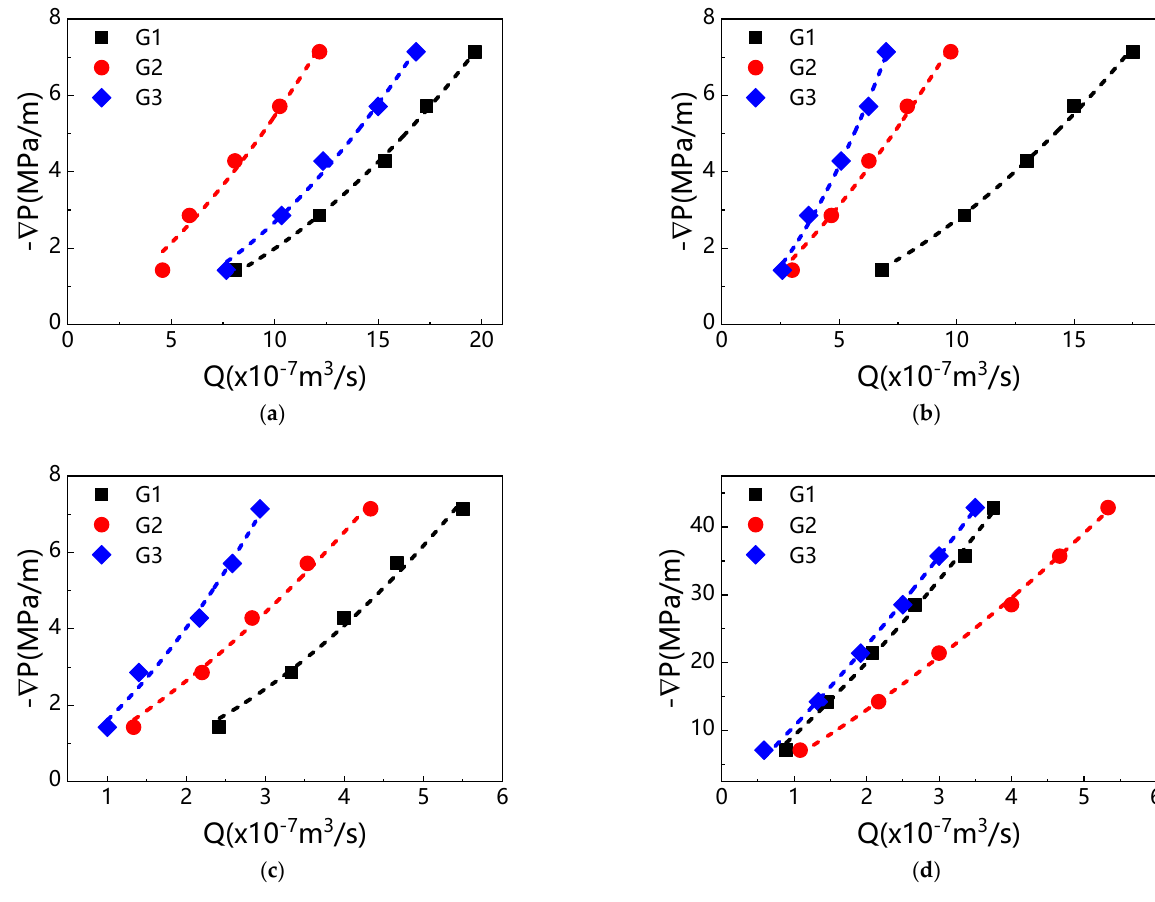
Figure 6. Relationship of ∇ P and Q for a fracture: ( a ) filled with 50 mesh quartz sand, ( b ) filled with 100 mesh quartz sand, ( c ) filled with 200 mesh quartz sand, and ( d ) without filling.